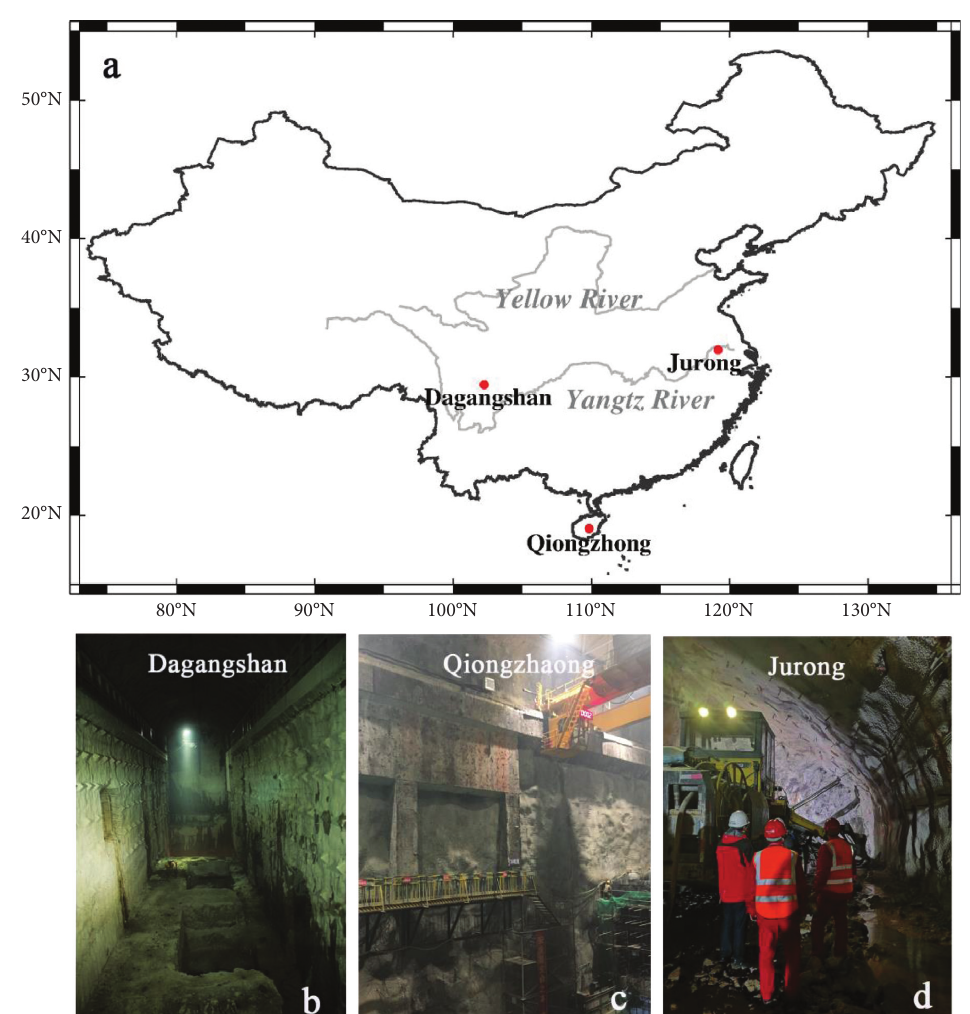
Figure 1: Sites selected for the investigation. The locations of three hydropower stations (a). The transformer chamber of Dagangshan station (b). The main powerhouse of Qiongzhong station (c). The traffic tunnel of Jurong station (d).